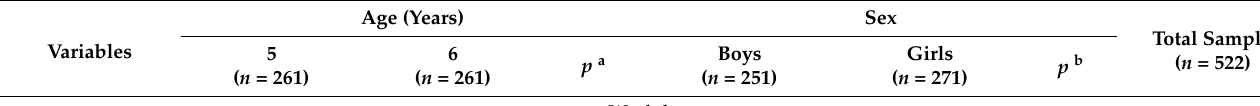
Table 3. Physical activity levels on weekdays and during weekends by age and